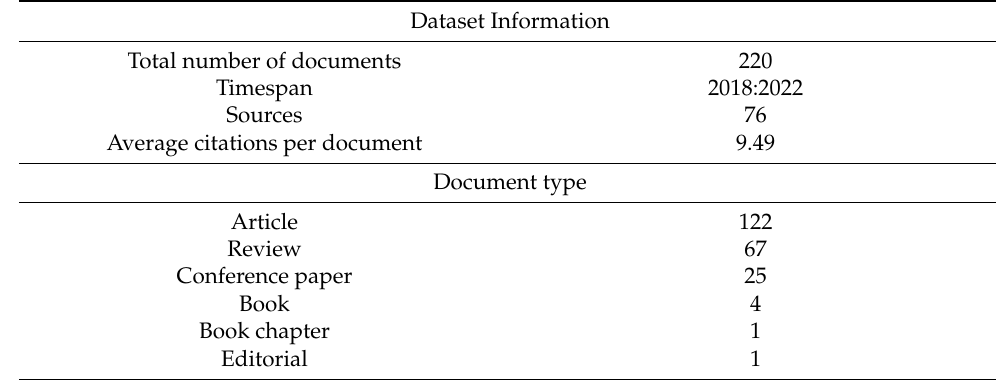
Table 3. Dataset